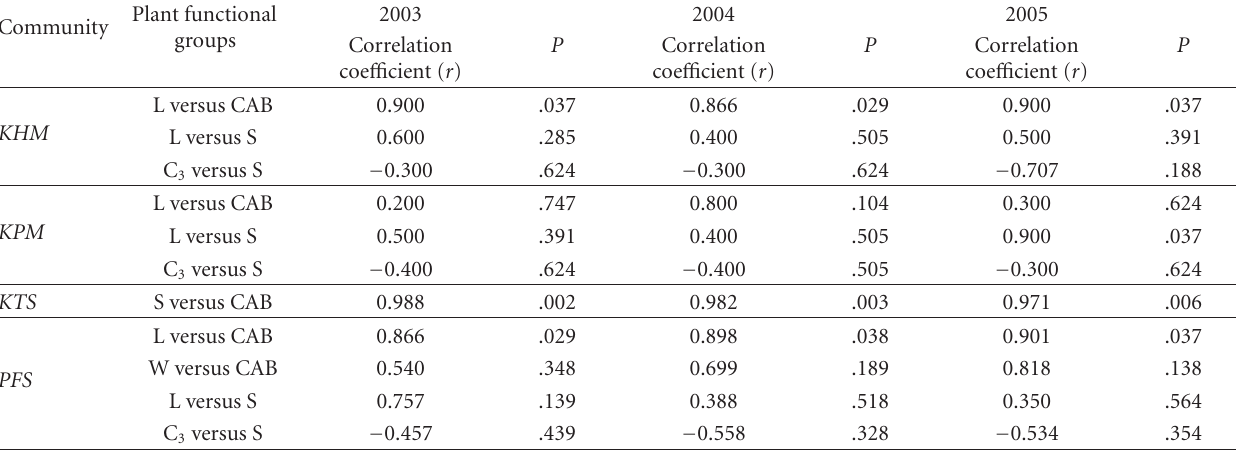
Table 3: Correlation coe ffi cients between plant functional groups and aboveground biomass. Spearman’s rank correlation coe ffi cients ( n = 10). L: Legumes; CAB: Community aboveground biomass; S, Sedges; C 3 : Grasses with the three-carbon photosynthetic pathway (C 3 ); W: Woody plants; Kobresia humilis meadow = KHM ; Kobresia pygmaea meadow = KPM ; Kobresia tibetica swamp meadow = KTS ; Potentilla fruticosa scrub = PFS